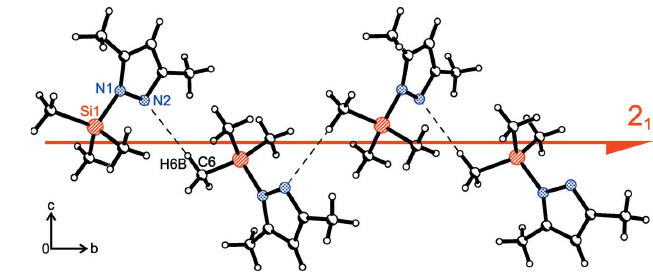
Figure 1 The molecular structure of the title compound, drawn with 50% probability displacement ellipsoids.